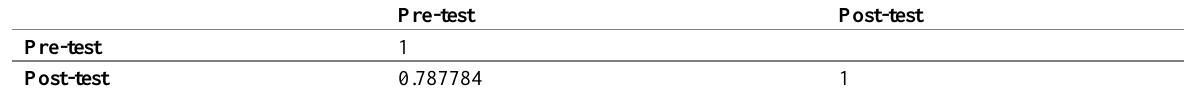
Table 4 : A Correlational Matrix to Determine Strength and Direction of Scatterplot Pre-test Post-test Pre-test 1 Post-test